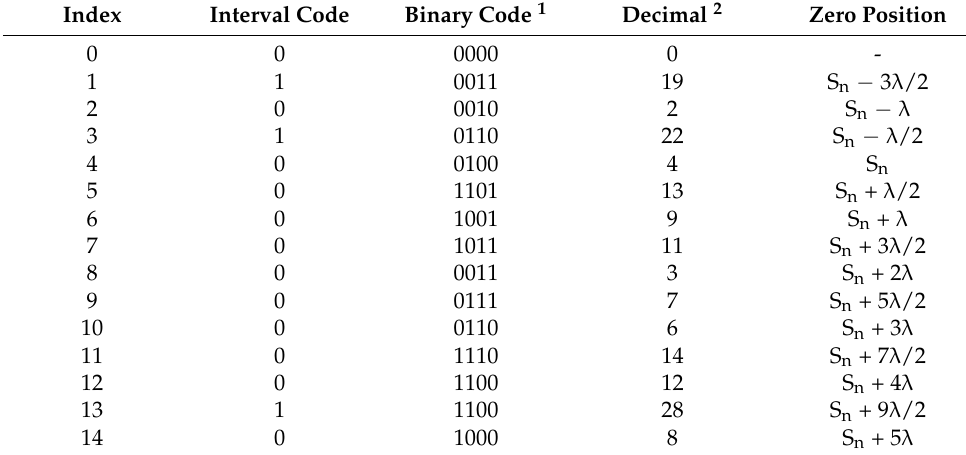
Table 1. Absolute displacement code